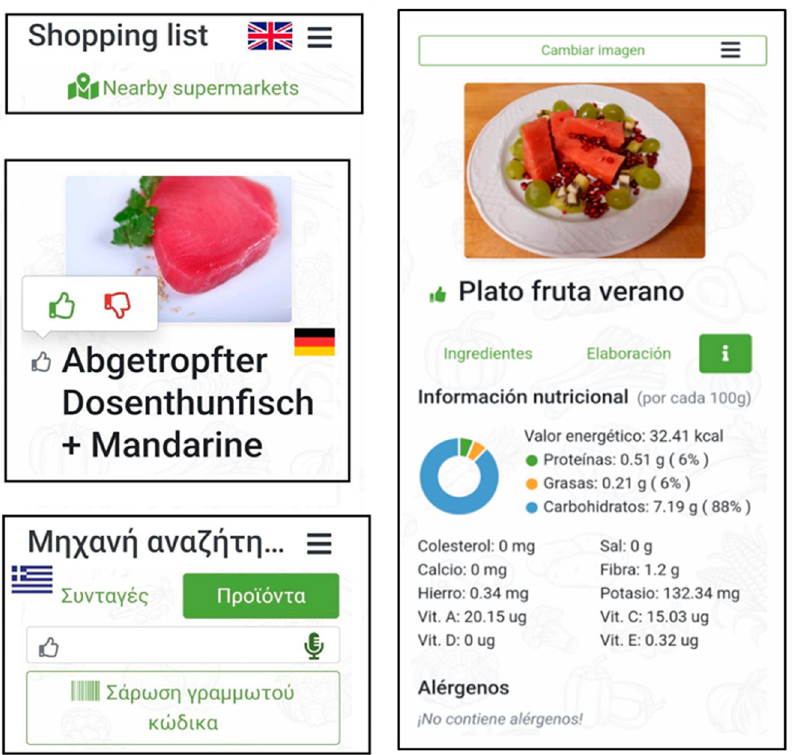
Figure 3. APP screenshots in four languages and different use levels. The four different languages used in the app are shown: left images, top (English), middle (German), bottom (Greek), right image (Spanish).